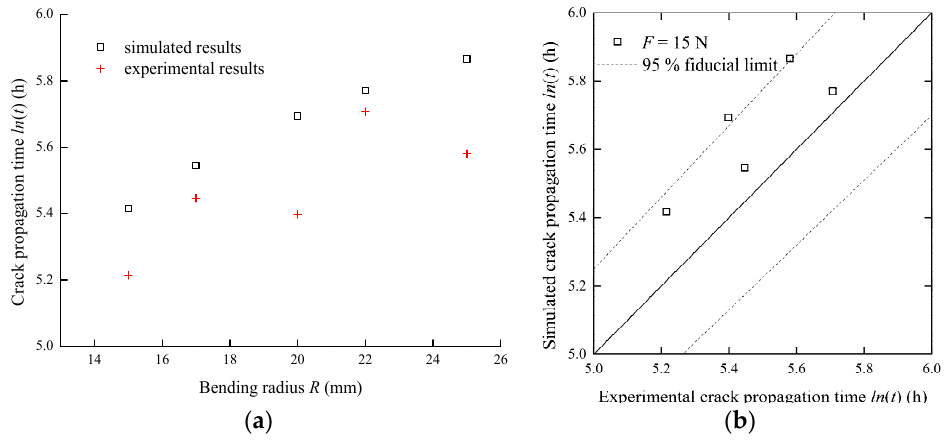
Figure 17. The comparison between the simulated and experimental crack propagation times under different bending radii: ( a ) crack propagation time vs bending radius; ( b ) simulated results vs experimental results.